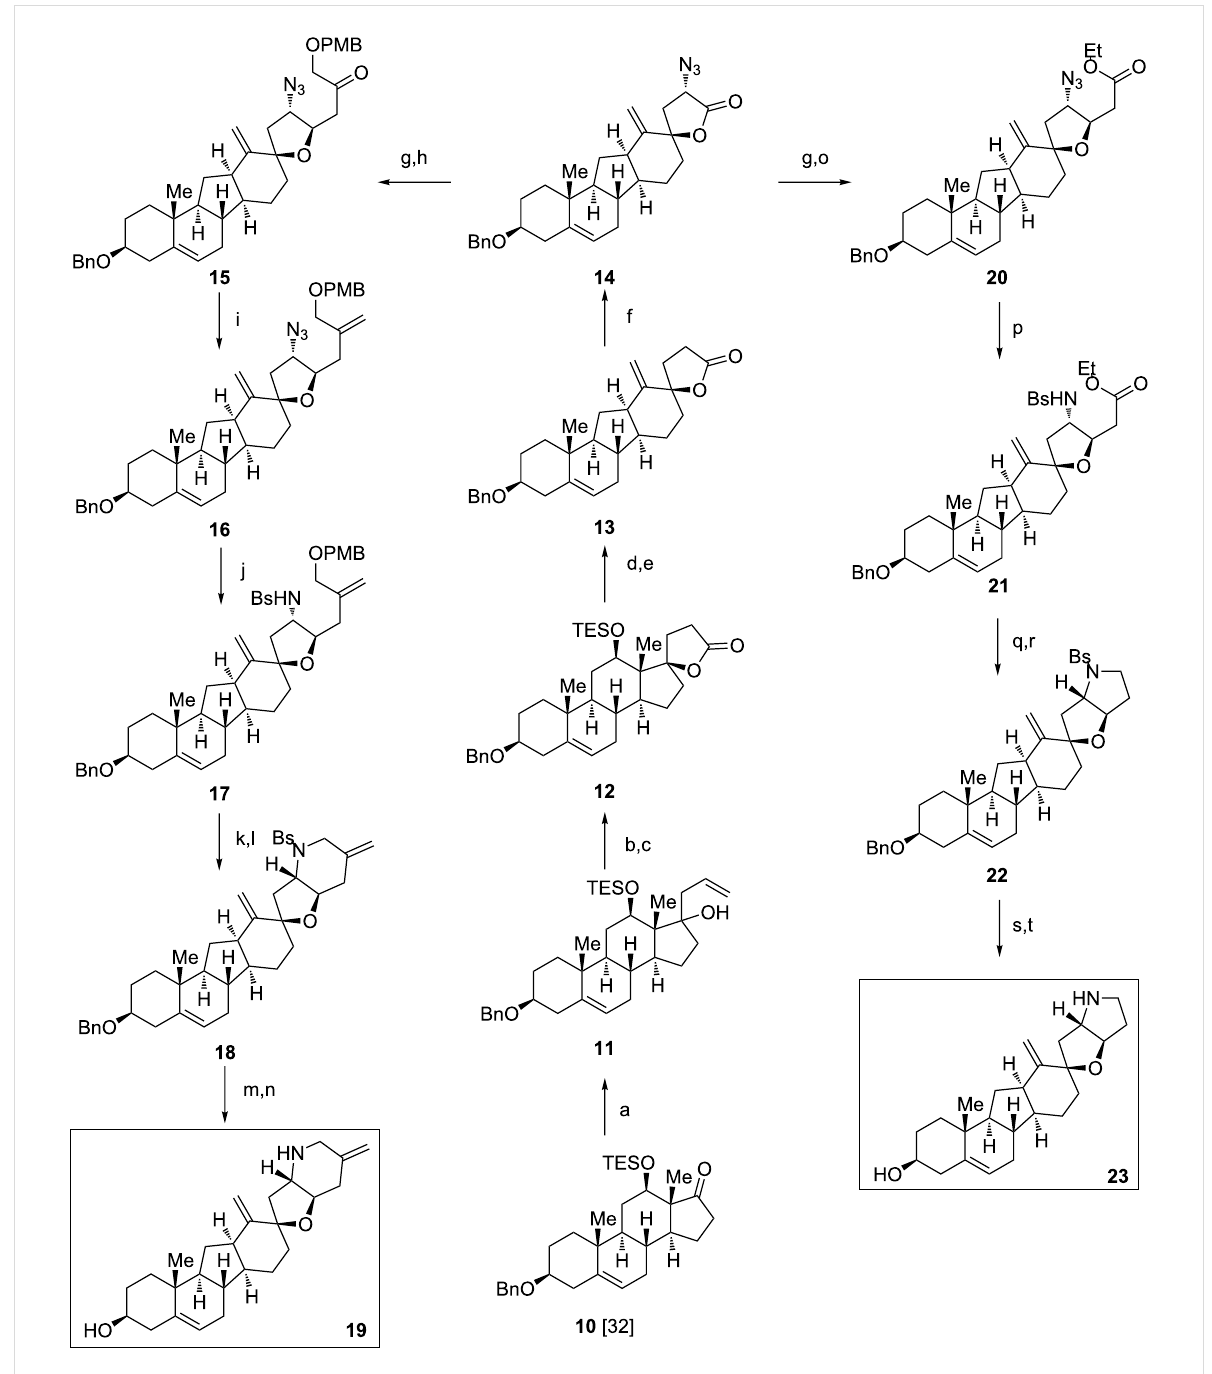
Scheme 2: Synthesis of 20-demethyl-bis- exo -cyclopamine 19 and F- nor -20,25-bis-demethyl- exo -cyclopamine 23 . Reaction conditions: (a) allyl- cerium chloride, THF, 0 °C, 30 min, 93%; (b) 9-BBN, THF, 70 °C, 6 h; then NaBO 3 , 50 °C, 12 h, 91%; (c) BAIB, TEMPO, CH 2 Cl 2 , 25 °C, 3 h, 73%;